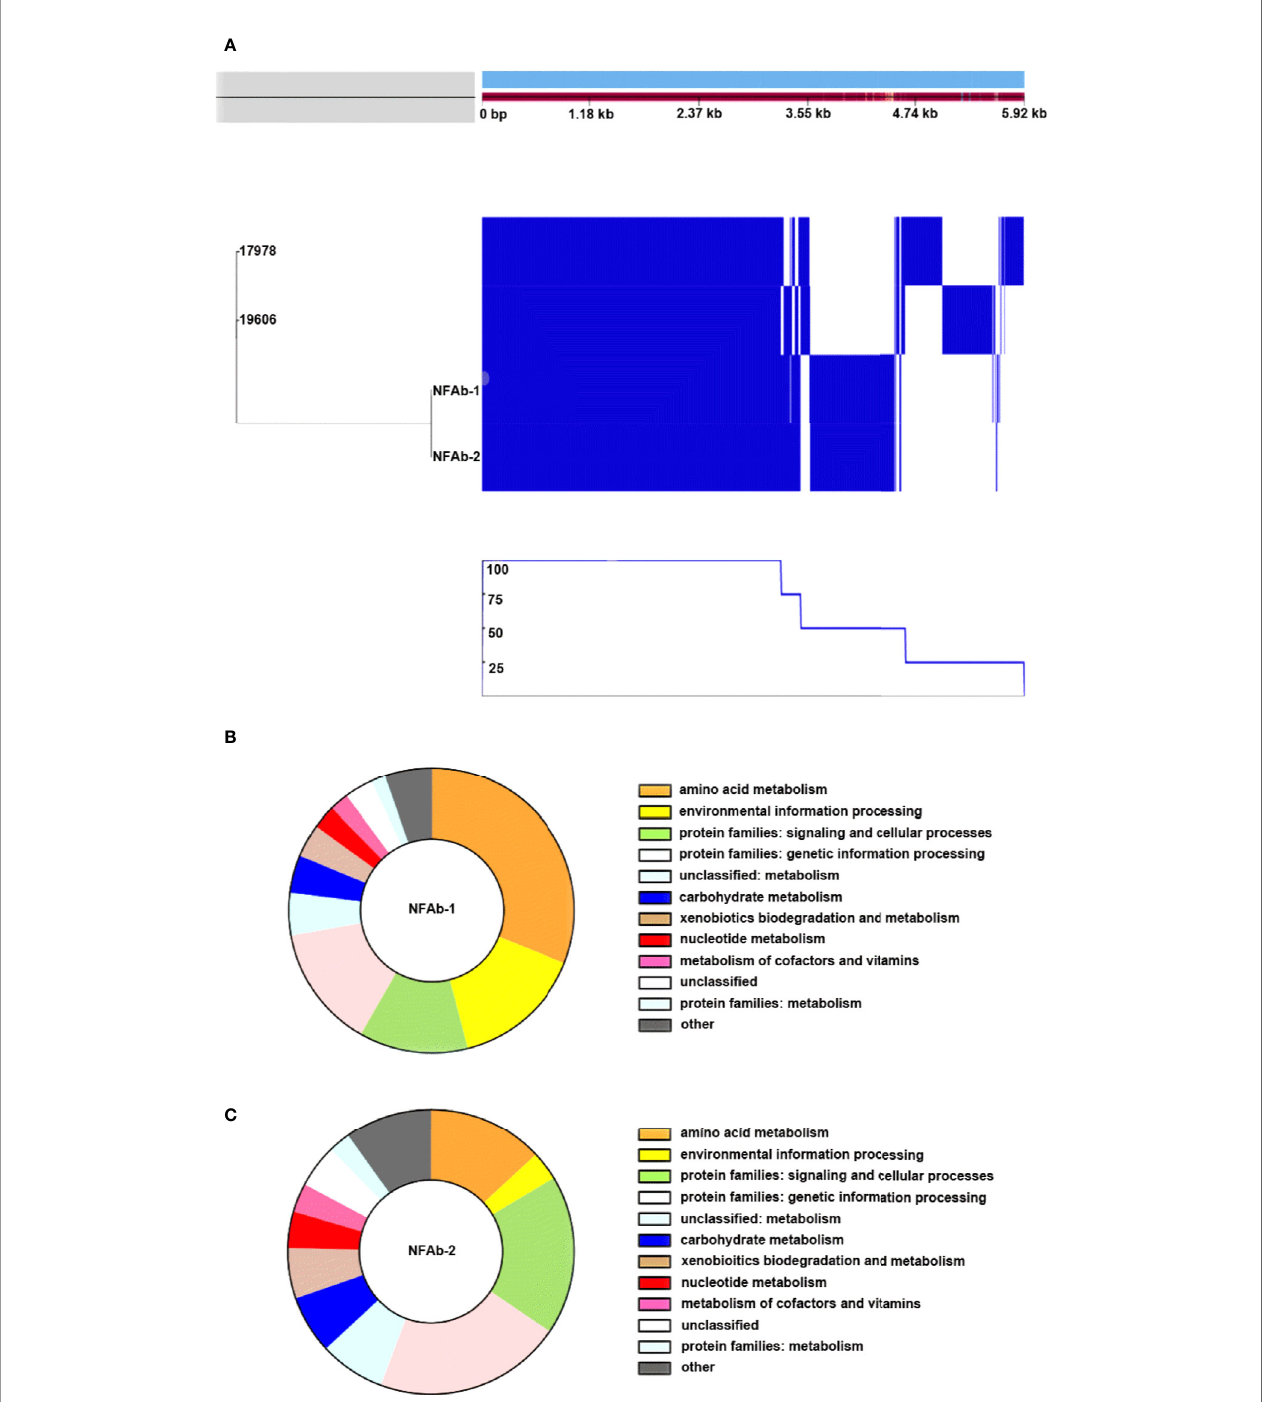
FIGURE 2 | Comparative analysis of A . baumannii genomes . A. baumannii ATCC 19606 T , ATCC 17978, NFAb-1 and NFAb-2 genomes were compared using ROARY and BlastKOALA. The relatedness of each isolate is seen at the left of (A) and the presence or absence of genes for each strain is seen in blue on the right with a corresponding line graph of the percent of strains harboring the above gene. The KEGG taxonomy analysis of NFAb-1 (B) and NFAb-2 (C) shows the predicted proteins that are unique to these isolates. The taxonomic groups are presented in the color-coded key to the right of each panel. (A) allows an estimation of the core genome shared between strains. The accessory genes of the necrotizing fasciitis isolates are further presented in (B, C) NFAb-1 has a greater percentage of proteins related to amino acid metabolism and environmental information processing than